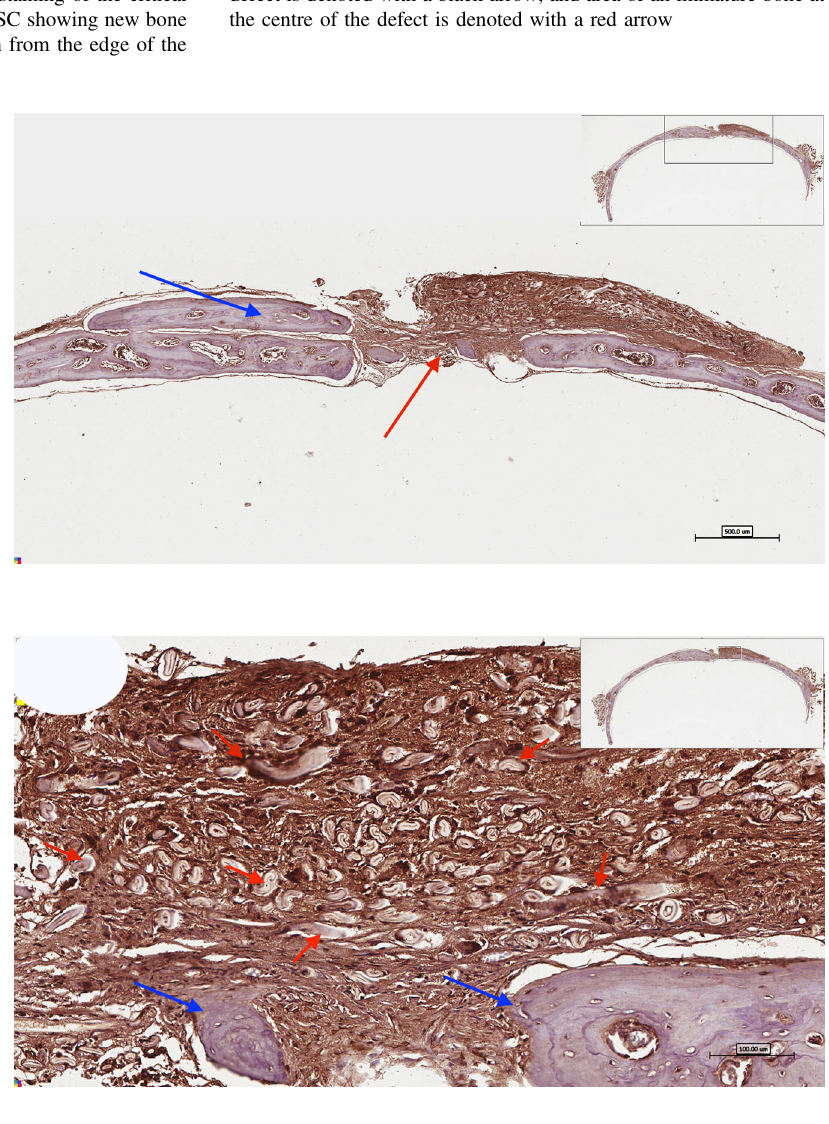
defect is denoted with a black arrow, and area of an immature bone at the centre of the defect is denoted with a red arrow